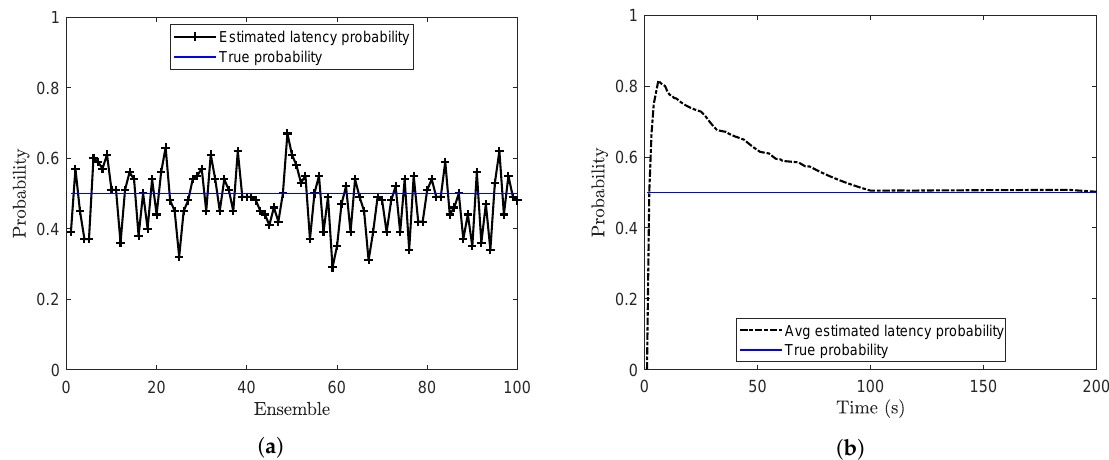
Figure 2. Estimation of the latency probability ( a ) Offline estimation ( b ) Online estimation (problem 1).